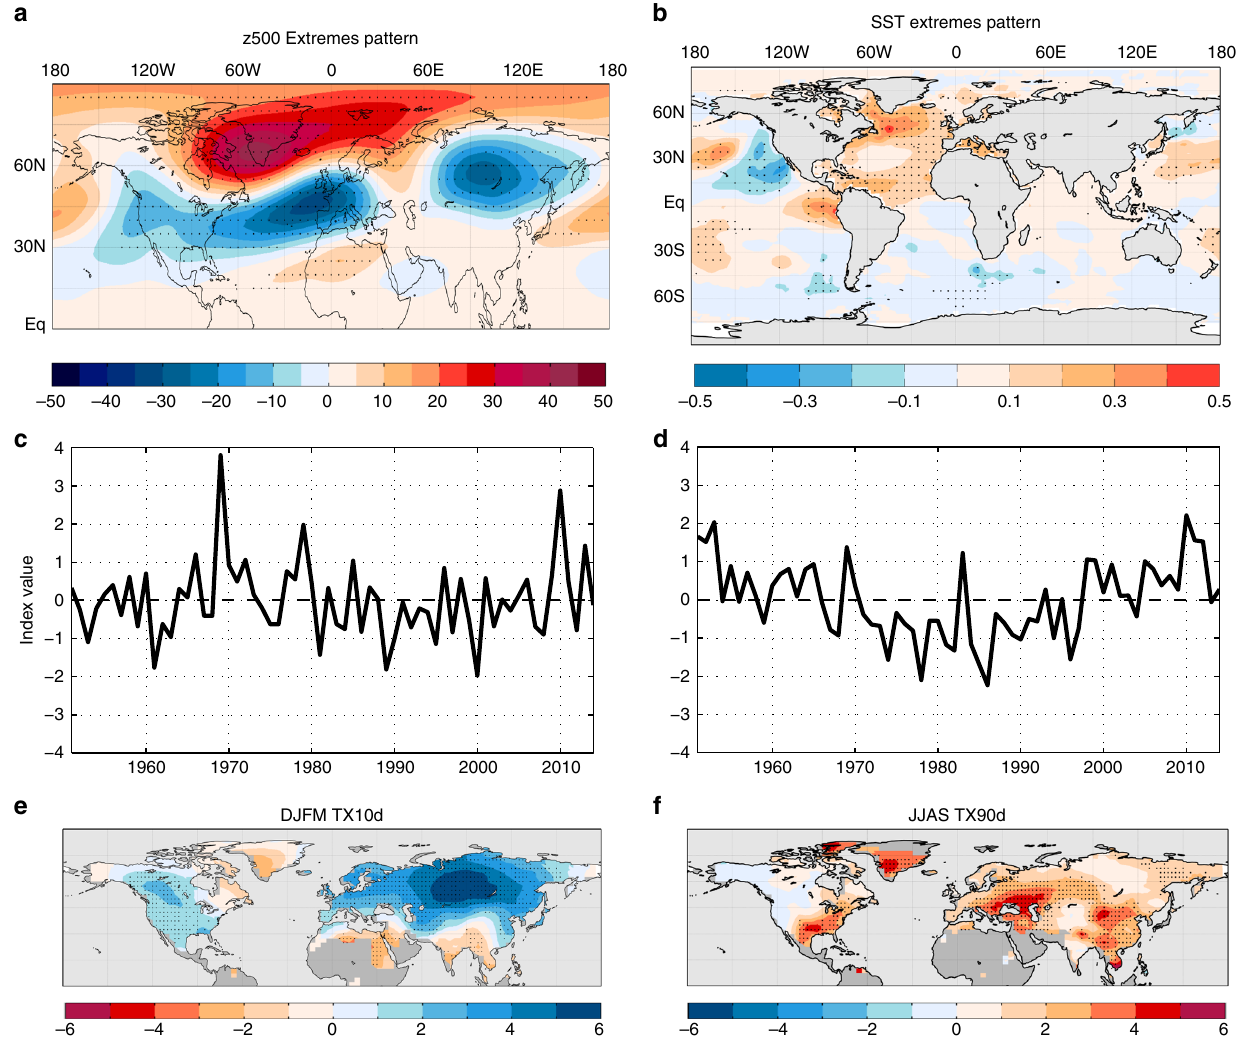
Fig. 3 The z500 and SST extremes patterns. The wintertime z500 (hPa) ( a ) and summertime SST (°C) ( b ) extremes patterns, where each pattern is a partial regression map representing the change of z500 or SST per standard deviation of the index time series (see Methods). c , d The standardized index time series corresponding with the z500 ( c ) and SST ( d ) extremes patterns. e , f Partial regression coef fi cients of wintertime cold extreme occurrences ( d season − 1 ) on the z500 extremes index ( e ) and summertime warm extreme occurrences on the SST extremes index ( f ). In the top and bottom panels, stippling indicates regression coef fi cients that are statistically signi fi cant at the 5% level based on a two-sided t -test for which the temporal degrees of freedom are adjusted for autocorrelation (see